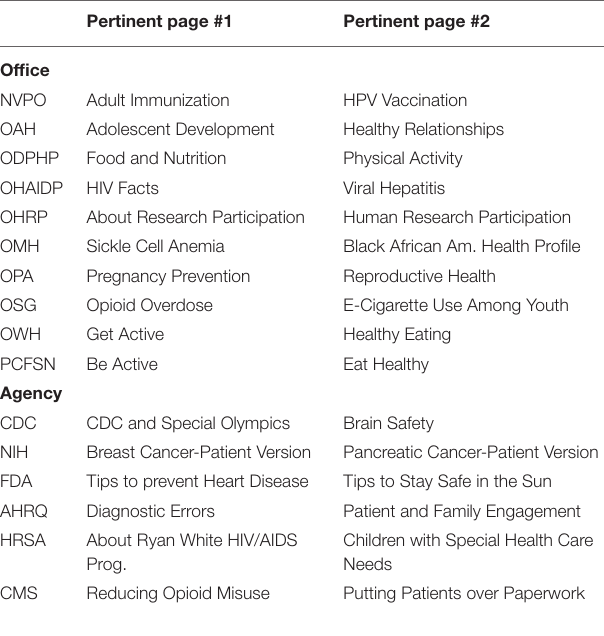
TABLE 4 | Pertinent pages.